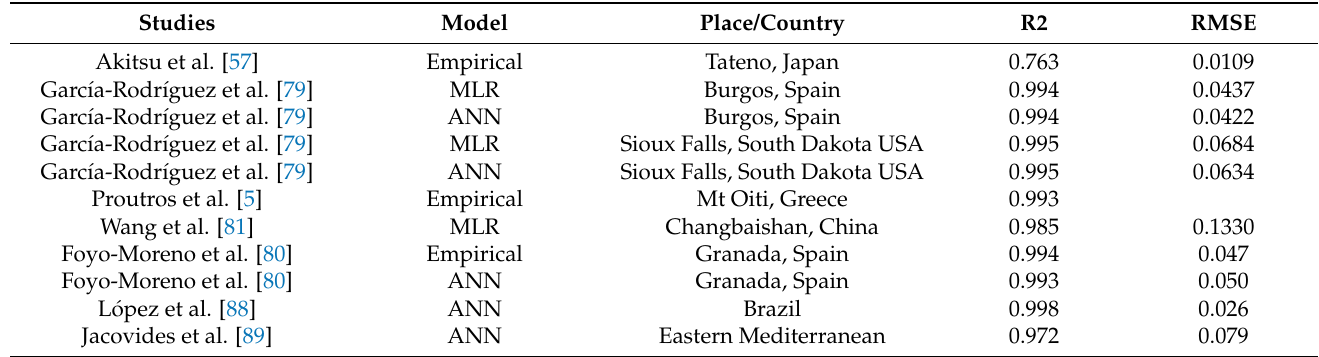
Table 9. A comparative analysis between developed hybrid models with various techniques in previous